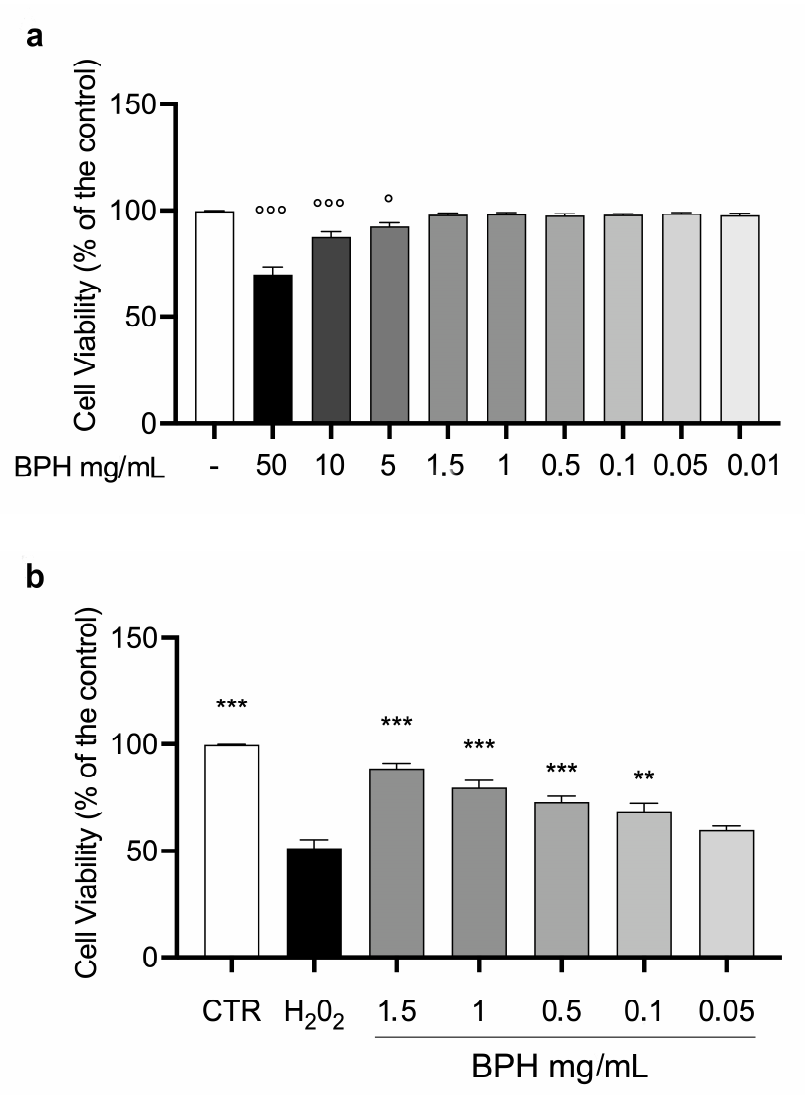
Figure 2. L-929 cell viability. ( a ) L-929 cell viability after 24 h of BPH exposure. ( b ) BPH protective effect against H 2 O 2 -induced cytotoxicity in L-929 cells. Data (mean ± SE) are representative of at least three independent experiments. °°° p < 0.001 vs. CTR; °° p < 0.01 vs. CTR; ° p < 0.05 vs. CTR; *** p < 0.001 vs. H 2 O 2 ; ** p < 0.01 vs. H 2 O 2 .